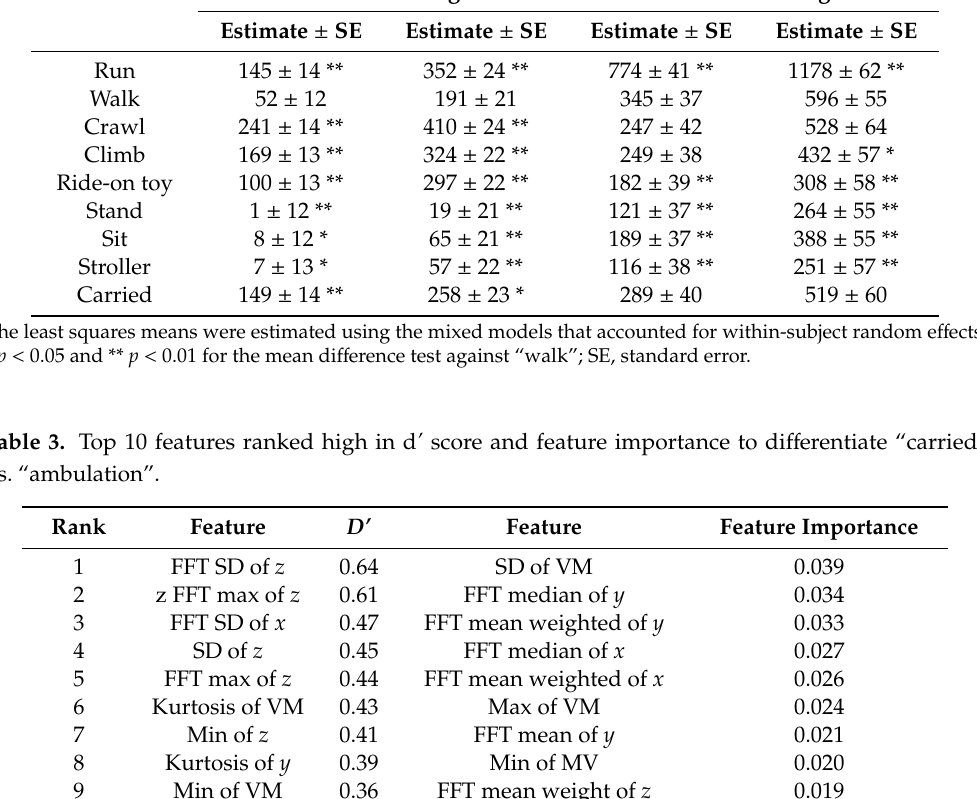
FFT, fast Fourier transform; SD, standard deviation; VM, vector